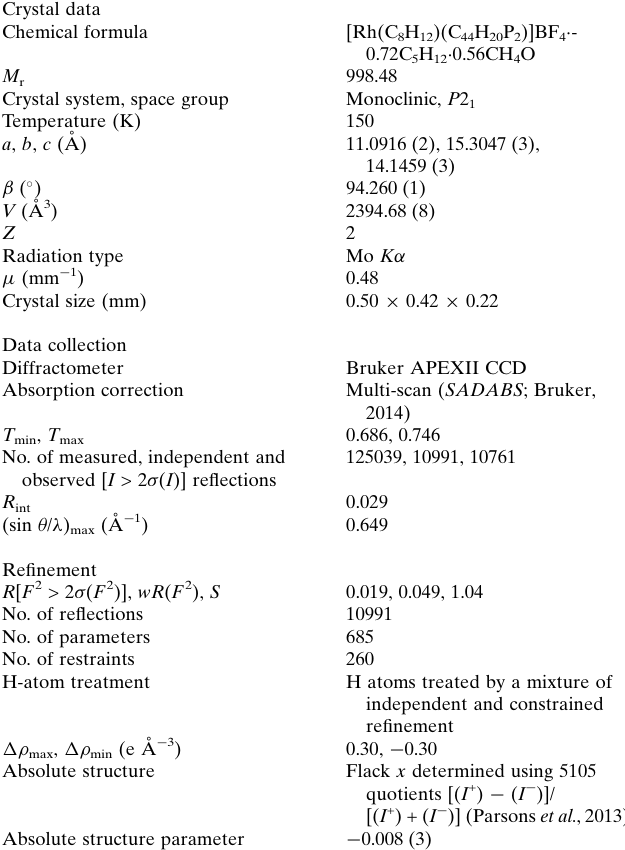
Table 2 Experimental details. Crystal data Chemical